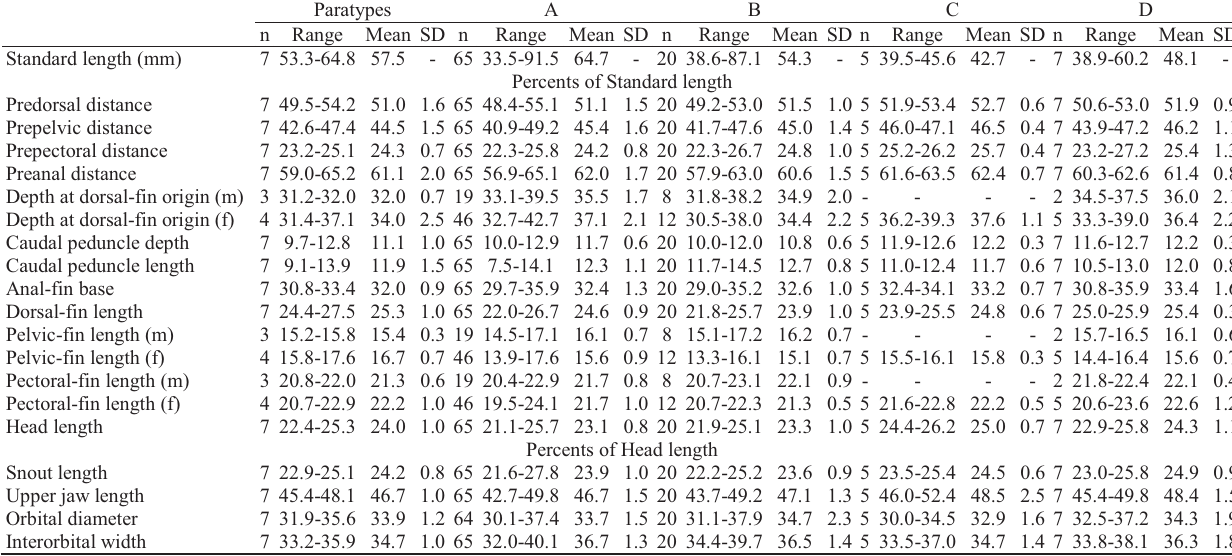
Table 6. Morphometric data of paratypes of Hemibrycon surinamensis (MHNG 2182.59, MNHN 1980.1435, ZMA 100.347) from Paramacca River basin, Suriname, and non-types from coastal drainages of the Guiana and Suriname (A - MHNG 1553.54-58, 2179.27, 2182.57, 2182.61-64, 2279.28, 2279.80; MNHN 1989.0046, 1994.0094, 1998.1780, 1998.1931, 2002.3511; ZMA 107.232, 107.275), from rio Tocantins basin (B - MZUSP 30529, 30530), from rio Tapajós basin (C - MNRJ 34433, 34435), and from rio Xingu basin, Brazil (D - MNRJ 34439, 34441, 34443). m, males; f, females. SD = Standard